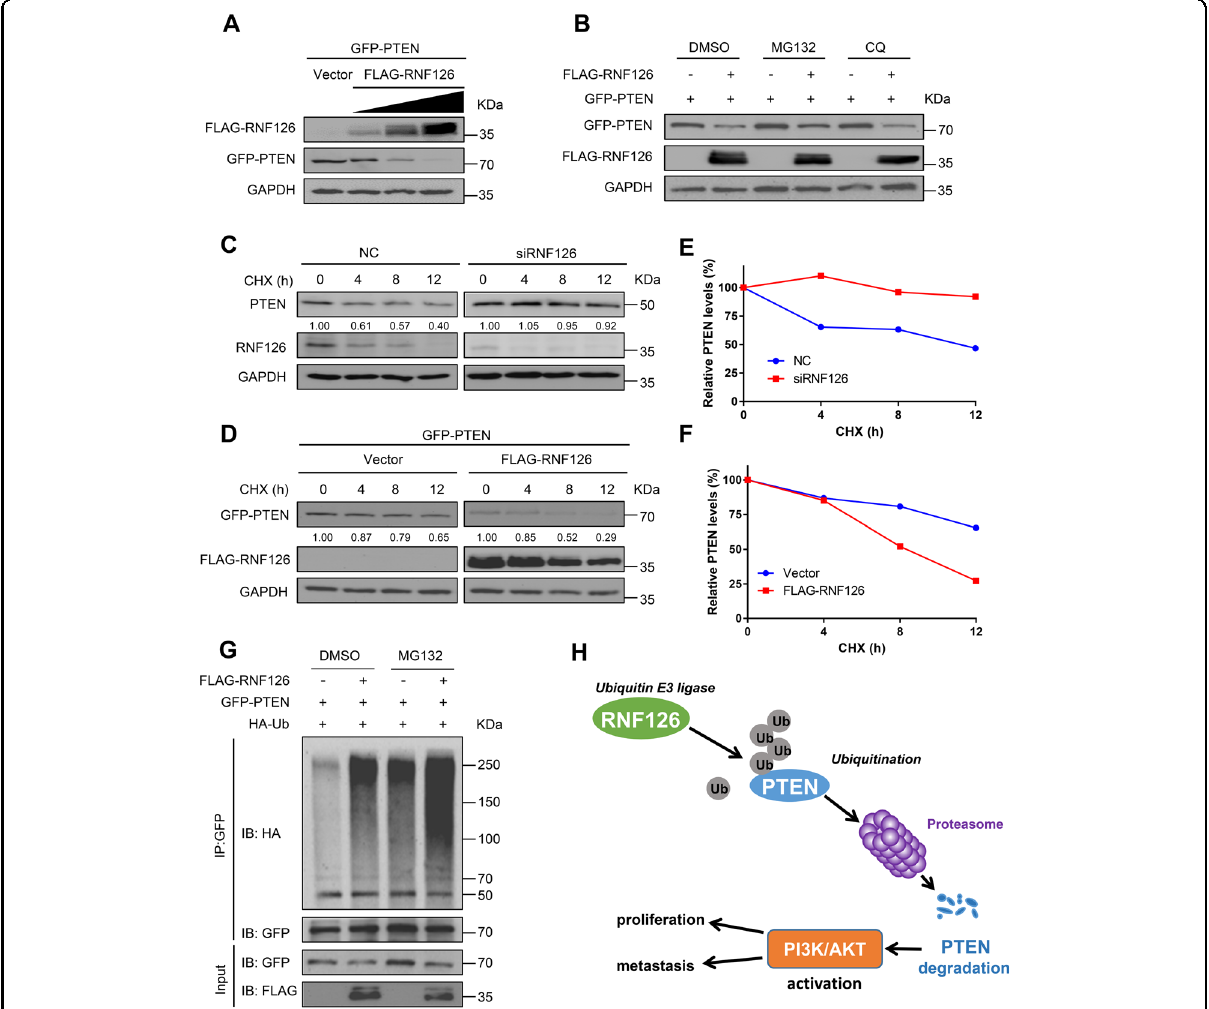
Fig. 5 RNF126 regulates the stability of PTEN. A The 293T cells were transfected with GFP-PTEN and FLAG-RNF126 plasmids at different doses 36 h, then the cells were collected, and anti-GFP antibodies were detected by western blotting to determine the level of exogenous PTEN. B GFP- PTEN and FLAG-RNF126 were transfected into 293T cells for 24 h, then the cells were treated with dimethyl sulphoxide (DMSO), 10 μ M MG132 (#S2619, Selleck) or 20 μ M chloroquine (CQ, #S8808, Selleck) for 8 h. The cells were collected and anti-GFP antibodies were detected by western blot. C FLAG-RNF126 plasmid was transfected into 293T cells, and then 100 μ g/ml cycloheximide (CHX, #S7418, Selleck) was respectively added at the speci fi ed time points for 0 h, 4 h, 8 h, and 12 h. Then, the cells were harvested, and western blot detected GFP antibodies to determine the half-life of GFP-PTEN protein. D The RNF126 siRNA was transfected into BCa 5637 cells for 36 h, and then 100 μ g/ml CHX was added at speci fi ed time points for 0 h, 4 h, 8 h, 12 h, and collect cells. The half-life of endogenous PTEN protein was determined by western blot. E , F The ImageJ v1.45 software was used to quanti fi ed PTEN protein abundance. The relative level of PTEN protein plotted as indicated. G The in vivo ubiquitination assay showed that RNF126 poly-ubiquitinated PTEN. HA-Ub, GFP-PTEN and FLAG-RNF126 plasmids were transfected into 293T cells for 36 h. The cells were treated with 10 μ M MG132 or DMSO for 8 h before harvest. H Graphic model of RNF126 affecting proliferation and metastasis through ubiquitination and degradation of PTEN in